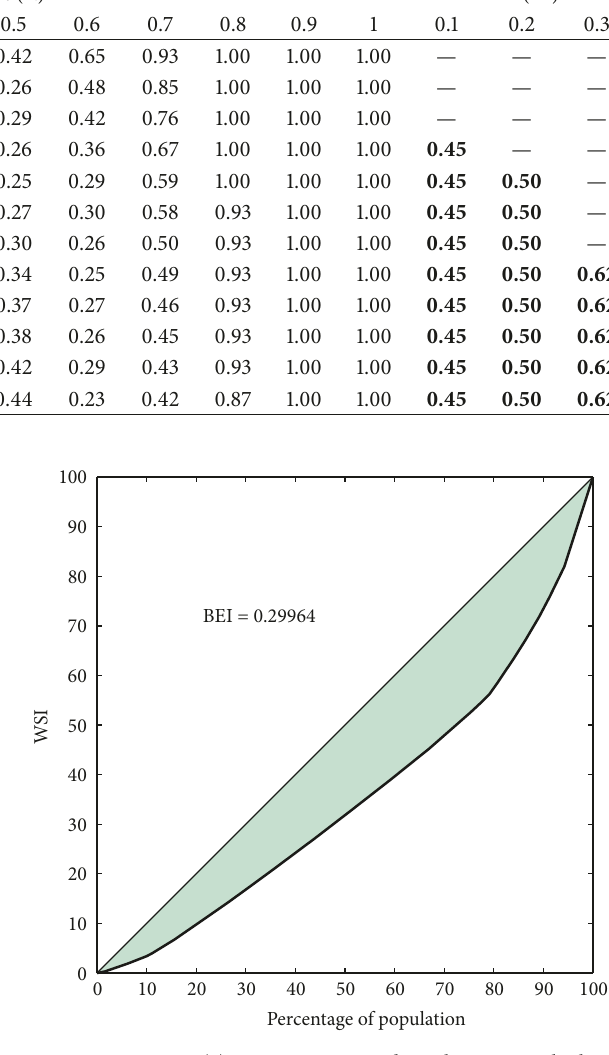
Figure 7: Scenario (1) : Lorenz curve and resulting BEI calculated with 𝑅